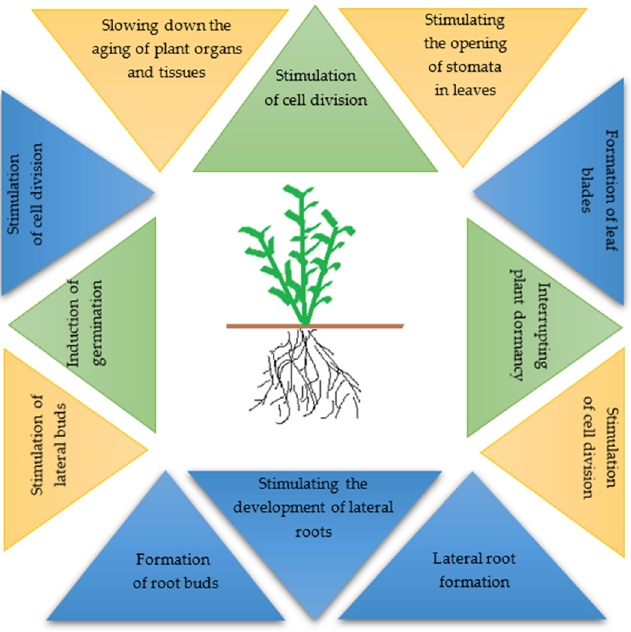
Figure 1. Functions of phytohormones. Auxins (blue); cytokinins (yellow); and gibberellins (green).